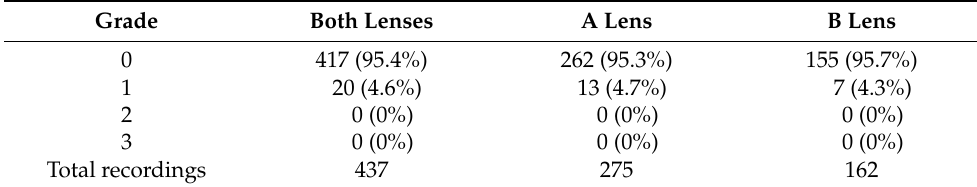
Table 2. Irritation scores (ocular discharge) for the A and B lenses.